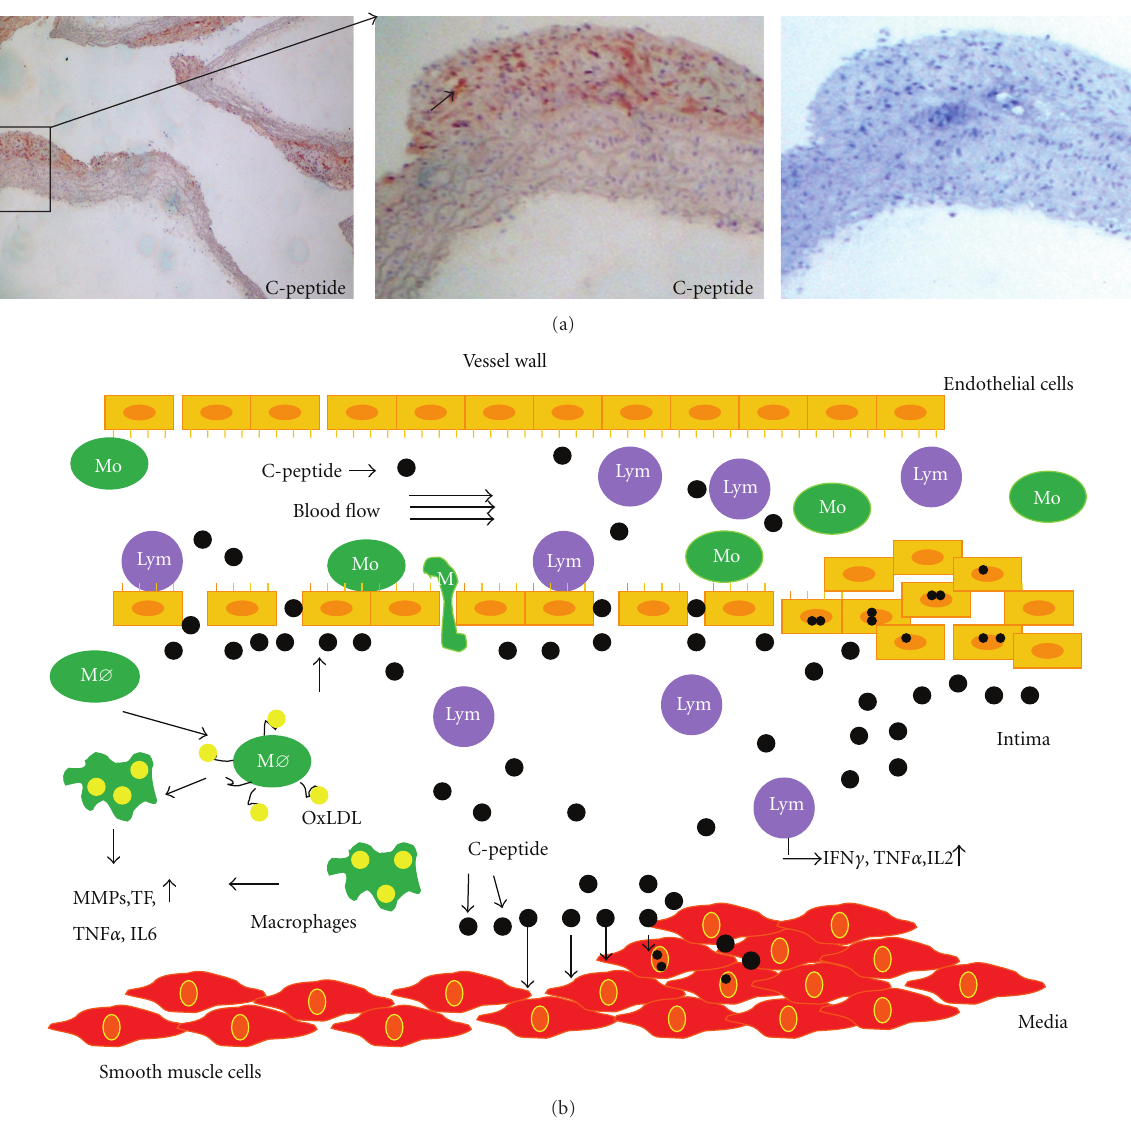
Figure 1: C-peptide deposits in mouse aortic arch. Red areas represent C-peptide deposition indicated by arrow on the high power view. Adjacent sections represent negative control and show no immunoreactive C-peptide areas (Figure 1(a)). Lower panel (Figure 1(b)) illustrates potential hypothesis about C-peptide e ff ects in vessel wall. Patients with insulin resistance and type 2 diabetes show increased levels of C-peptide in the blood. Together with endothelial dysfunction and increased endothelial permeability C-peptide deposits in the intima of the vessel wall and from there induces recruitment of inflammatory cells and their migration into the subendothelial layer. C-peptide deposits also in the media and has an e ff ect on the proliferation of smooth muscle